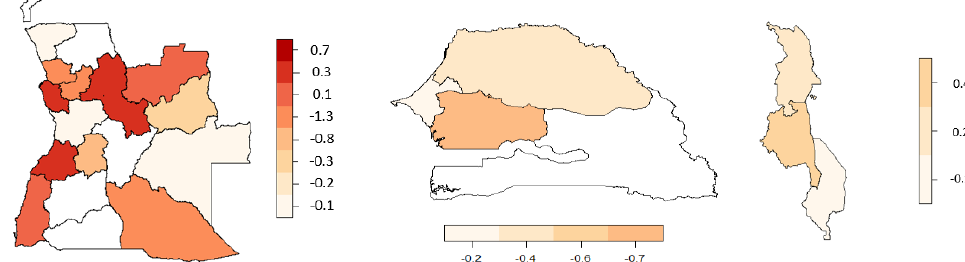
Figure 4. Estimated effect of the structured spatial effect on malnourishment. ( Left ) Angola, ( mid- dle ) Senegal, and ( right ) Malawi.